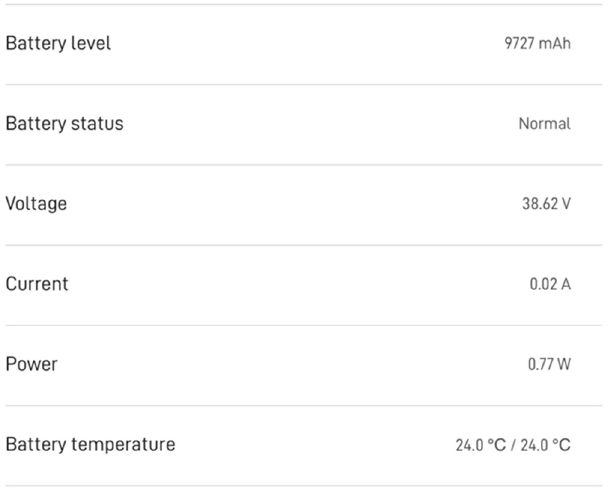
Figure 1. Sample data that could be read during the measurements.